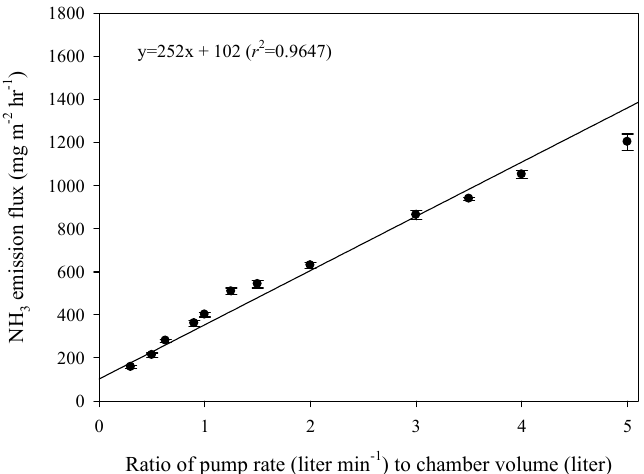
Figure 4. Changes in ammonia emission flux with different ventilation rate (min − 1 ) using dynamic chamber-capture system at 20 °C condition. Error bar means standard deviation (SD, n = 3).